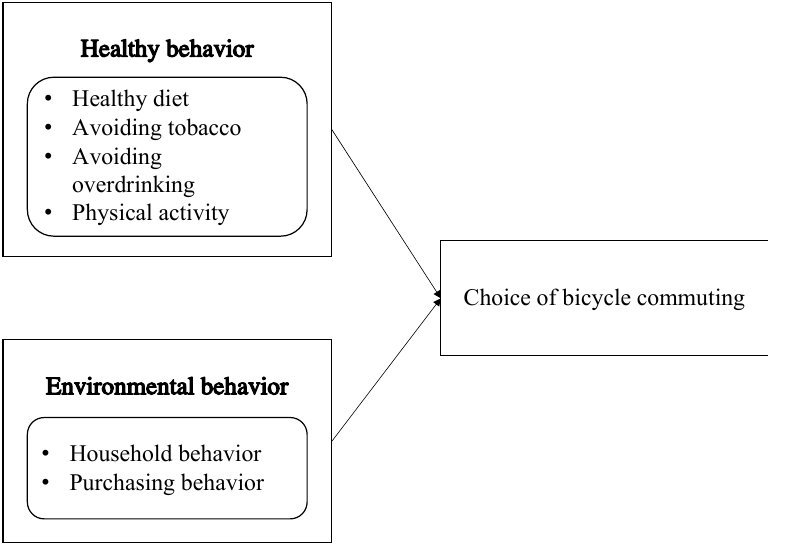
Figure 1. The research framework.